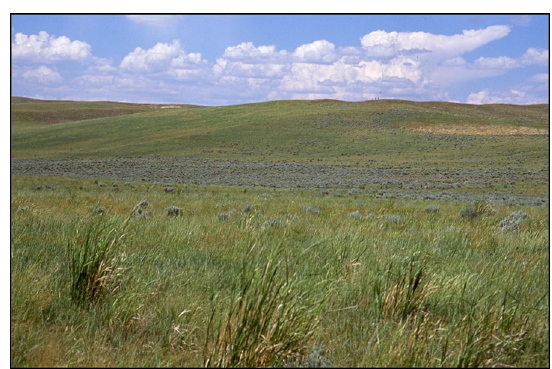
Fig. 10 Landscape mosaic of multiple communities